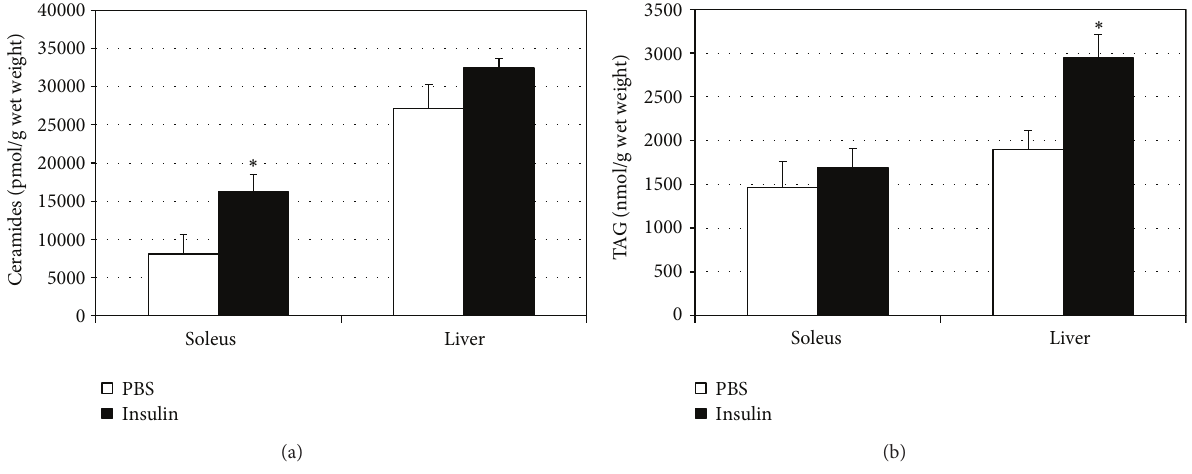
Figure 7: Following treatment period, soleus and liver were dissected from adult male mice receiving insulin (INS, 50 nM) or vehicle (PBS) injections every morning for 14 d. Ceramides (a) and TAG (b) were quantified from both tissues. ∗ 𝑃 < 0.05 , insulin versus